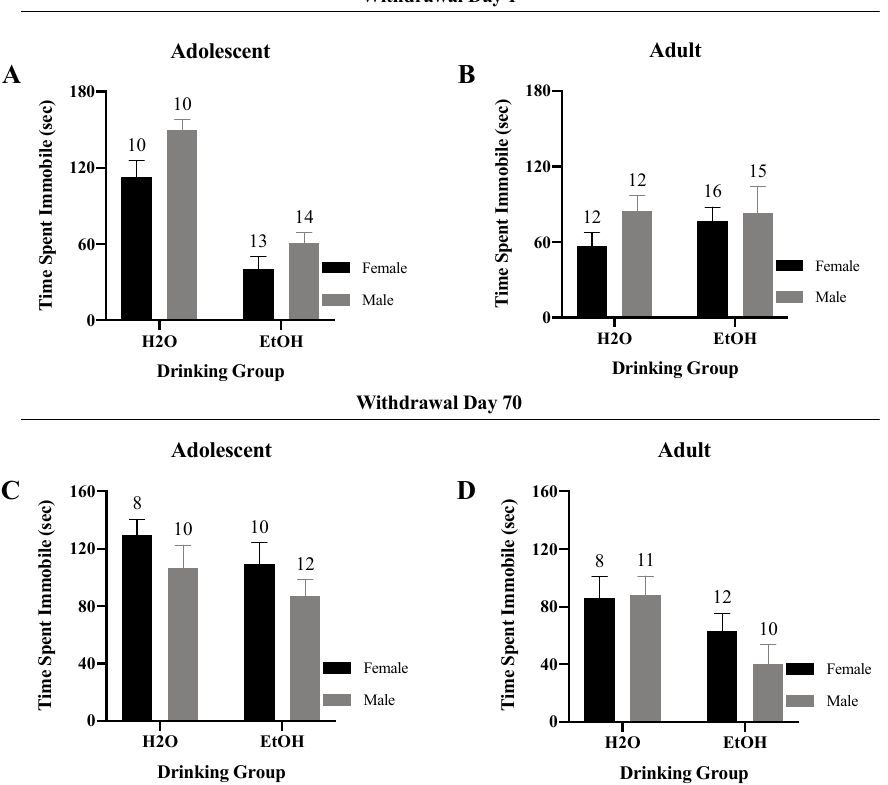
Figure 10. Summary of the results for the Sex × Drinking ANOVA observed for the total time spent immobile in the Porsolt Forced Swim Test. ( A ) Depiction of the results for the adolescent-onset mice at 1-day withdrawal. ( B ) Depiction of the results for the adult-onset mice at 1-day withdrawal. ( C ) Depiction of the results for the adolescent-onset mice at 70-days withdrawal. ( D ) Depiction of the results for the adult-onset mice at 70-days withdrawal. The data represent the means ± SEMs for the numbers of mice indicated in each panel.